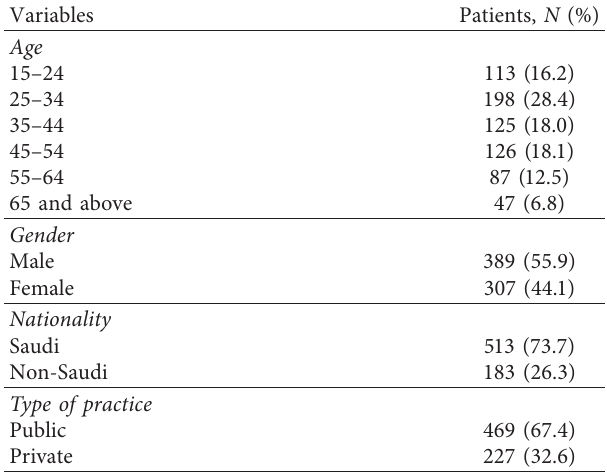
Table 1: Demographic information of patients ( N �